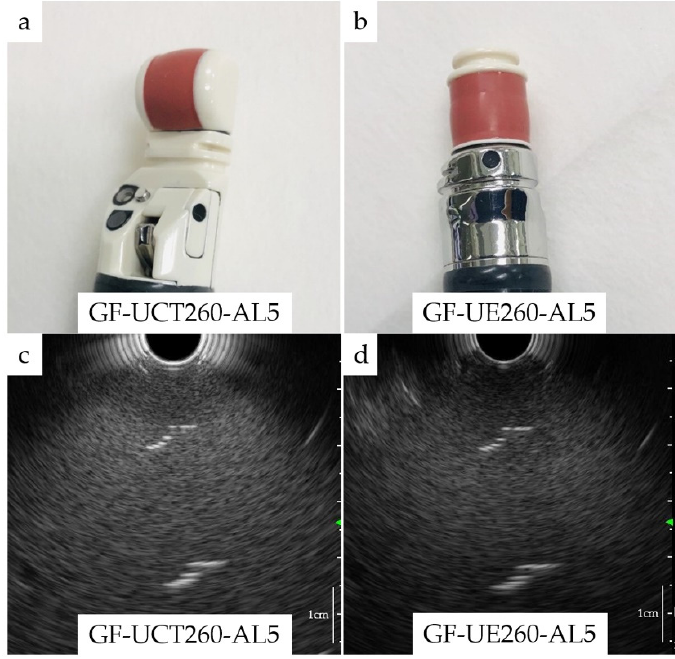
Figure 2. Two types of echoendoscopes and the image of a thread. ( a ) Convex-arrayed array echoendoscope (GF-UCT240-AL5/GF-UCT260-AL5, Olympus Corporation, Tokyo, Japan); ( b ) radial-arrayed echoendoscope (GF-UE260-AL5, Olympus Corporation, Tokyo, Japan); ( c ) image of a thread hanging in water by GF-UCT260-AL5; ( d ) image of a thread hanging in water by GF-UE260-AL5.